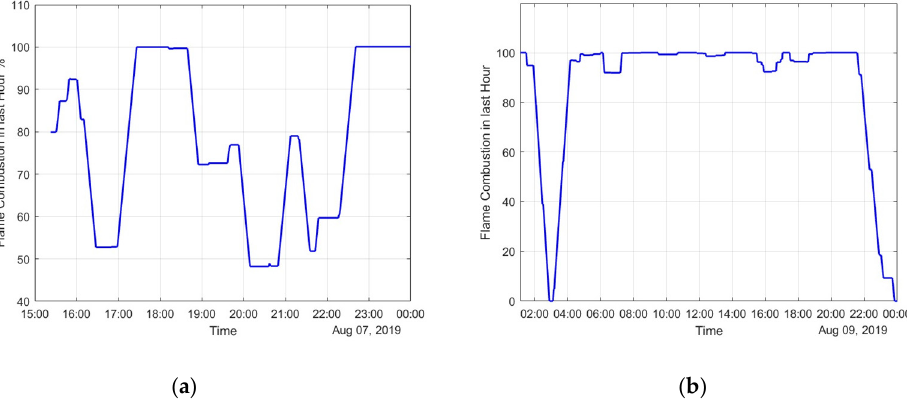
Figure 12. Value over time of the % of “good combustion” during the last 60 min. In case ( a ), the probe shows the variability of this parameter and as well a no negligible proportion of time with a value under the reference. For the ( b ) there is more stable operation and with almost the entire day with the parameter close to 100%.